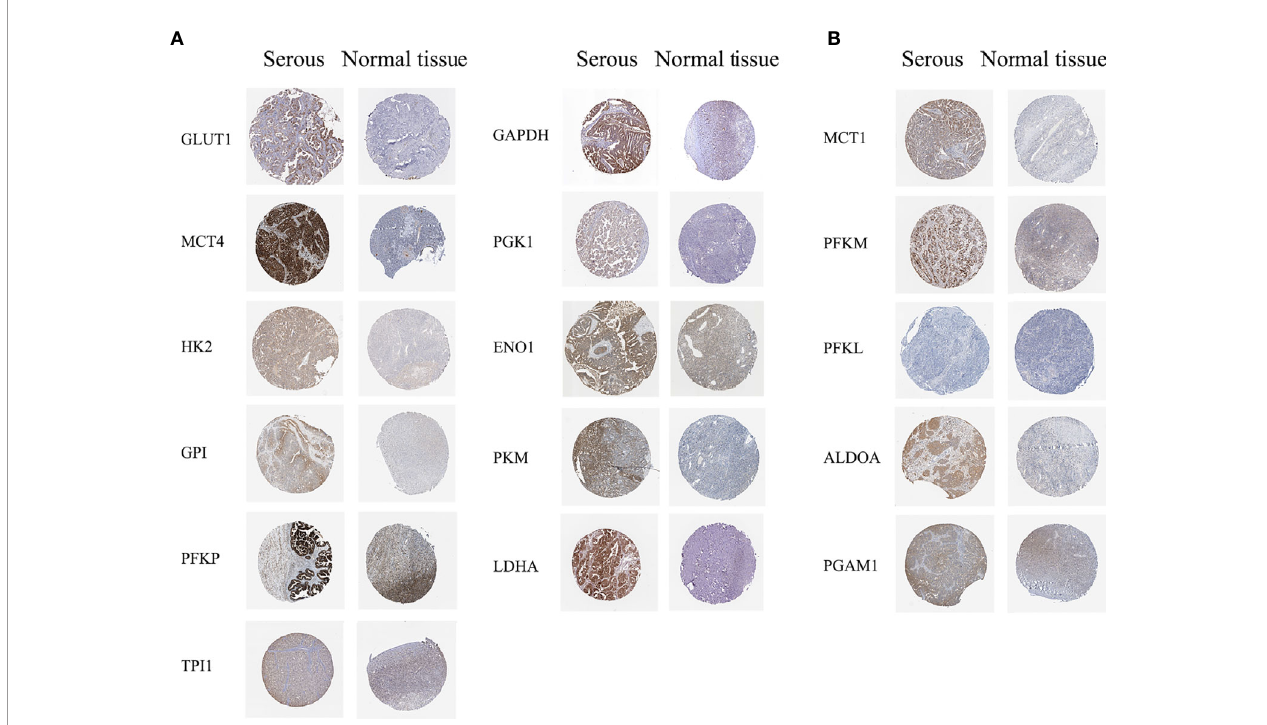
FIGURE 2 | Protein expression levels of glycolysis-related genes (HPA dabatase). (A) Protein expression levels of high expression glycolysis-related genes. (B) Protein expression levels of other glycolysis-related